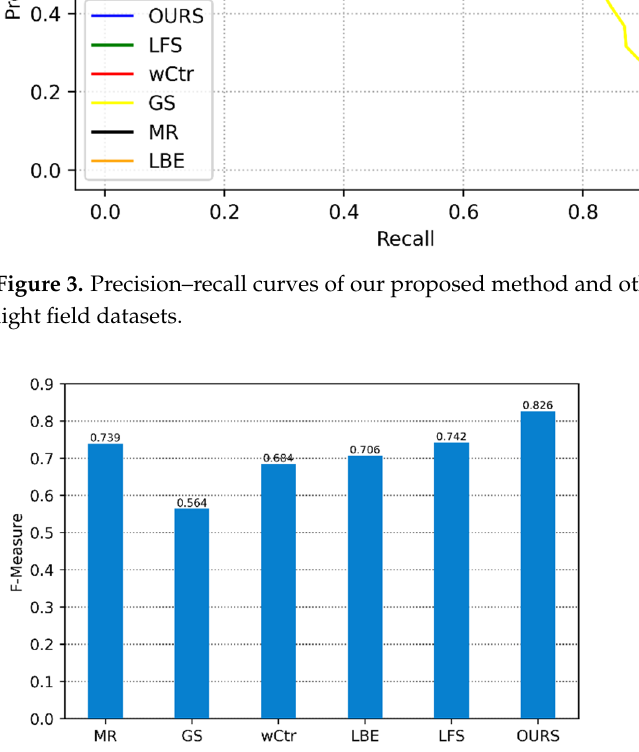
Figure 4. F ‐ Measure of our proposed method and other salient object detections in the light field datasets.